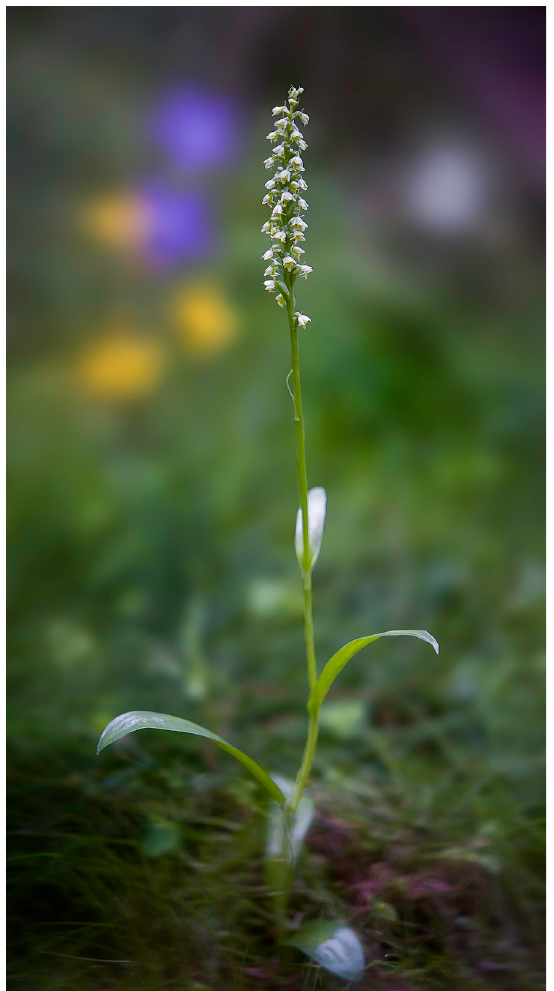
Fig 5. Pseudorchis albida (L.) A´.Lo¨ve & D.Lo¨ve subsp. tricuspis (Beck) E.Klein entire plant in its natural habitat (Fig 5), details of the inflorescences (Figs 6 and 7). One of the inflorescences (Fig 7) is visited by hoverfly of the family Syrphidae Latreille, 1802. The hoverflies, which are true bee-mimics, are also very frequent visitors of Pseudorchis albida subsp. tricuspis , although it has not been shown to be its real pollinators, as of yet. Figs 5–7 © 2019 N. Anghelescu